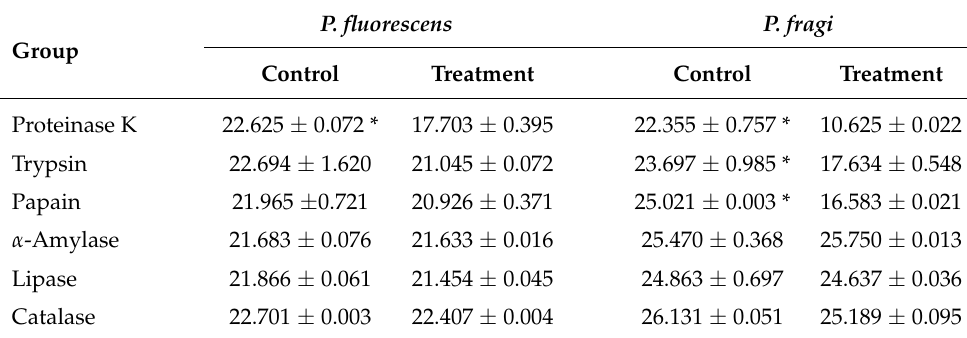
Table 2. Protease validation experiment.